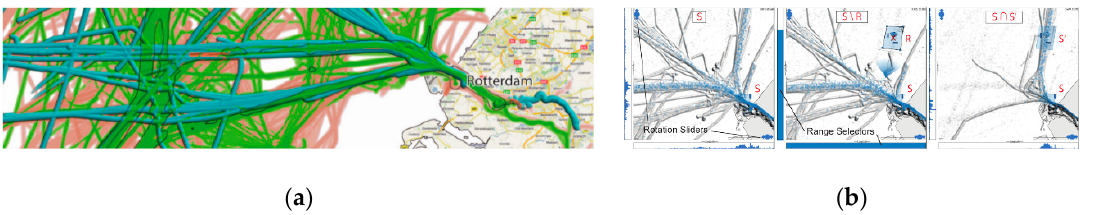
Figure 12. Density-map visualizations of traffic trajectory data ( a ) composite density map of vessel-accident risks [42]; and ( b ) density map combined with a particle system [43].